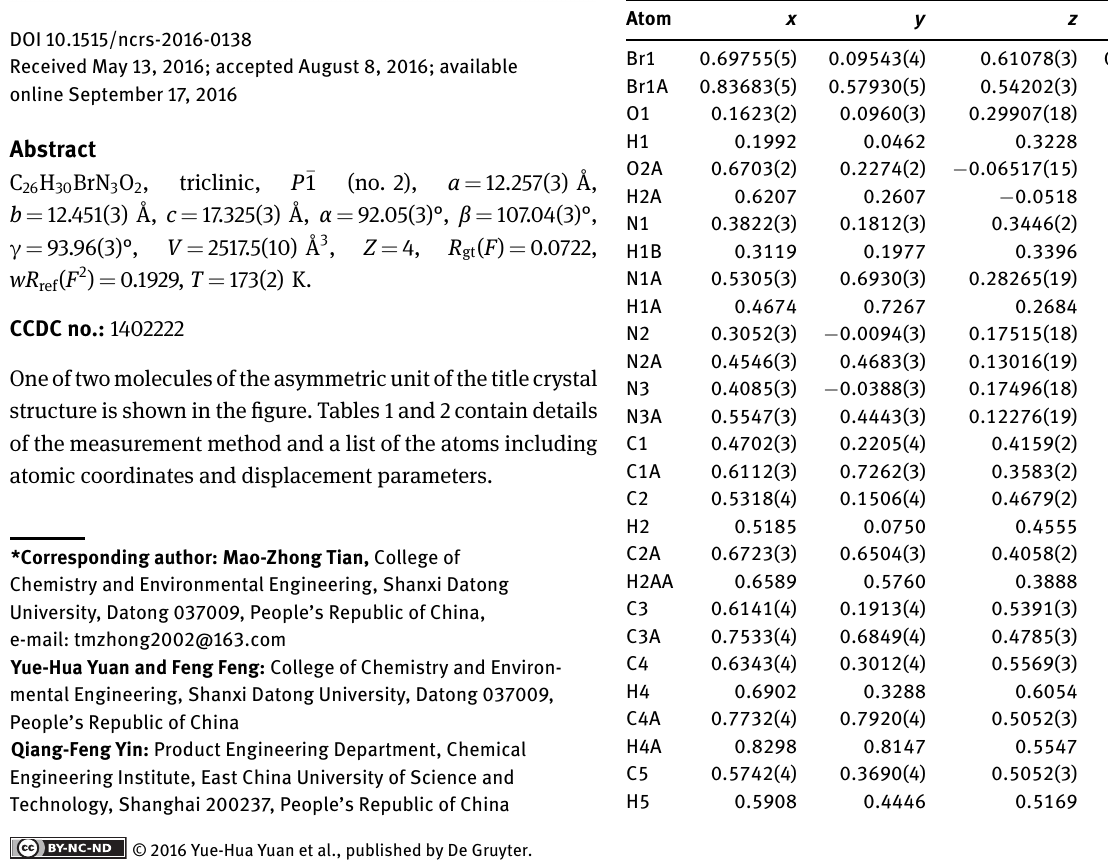
Table 2: Fractional atomic coordinates and isotropic or equivalent isotropic displacement parameters (Å 2